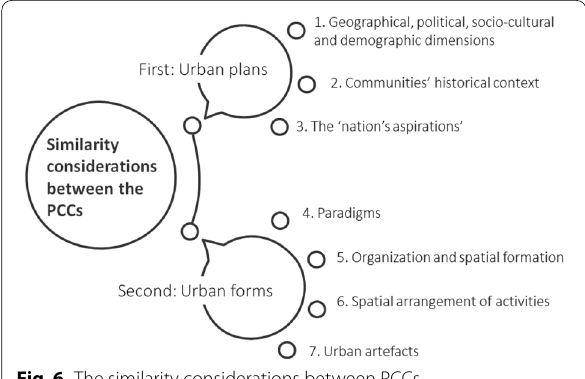
Fig. 6 The similarity considerations between